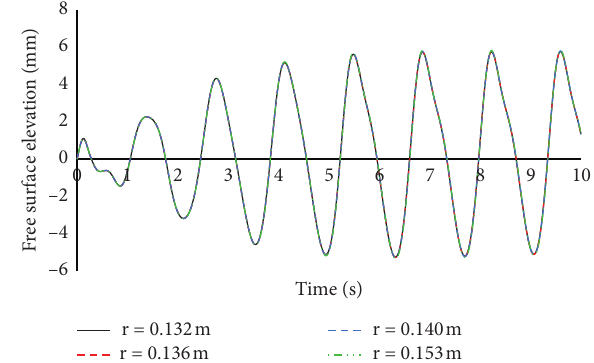
Figure 21: Contrast of wave heights on free surface of different radian